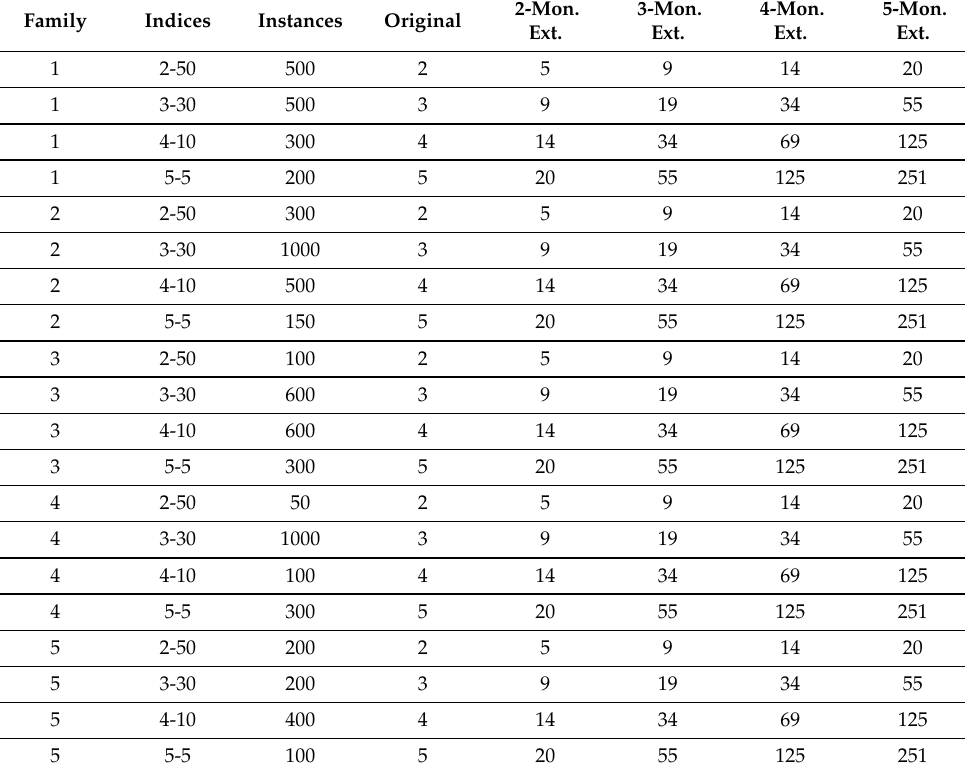
Table A6. Basic information about the artificial datasets. The column “Family” denotes the corre- sponding family function. The column “Indices” denotes the number of features and their cardinality. The column “Instances” denotes the number of entries in the dataset. The column “Original” denotes the number of features in the original dataset. The columns “2-Mon. Ext.”, “3-Mon. Ext.”, “4-Mon. Ext.”, and “5-Mon. Ext.”, denote the number of features in the 2-monomial extension, 3-monomial extension, 4-monomial extension, and 5-monomial extension,